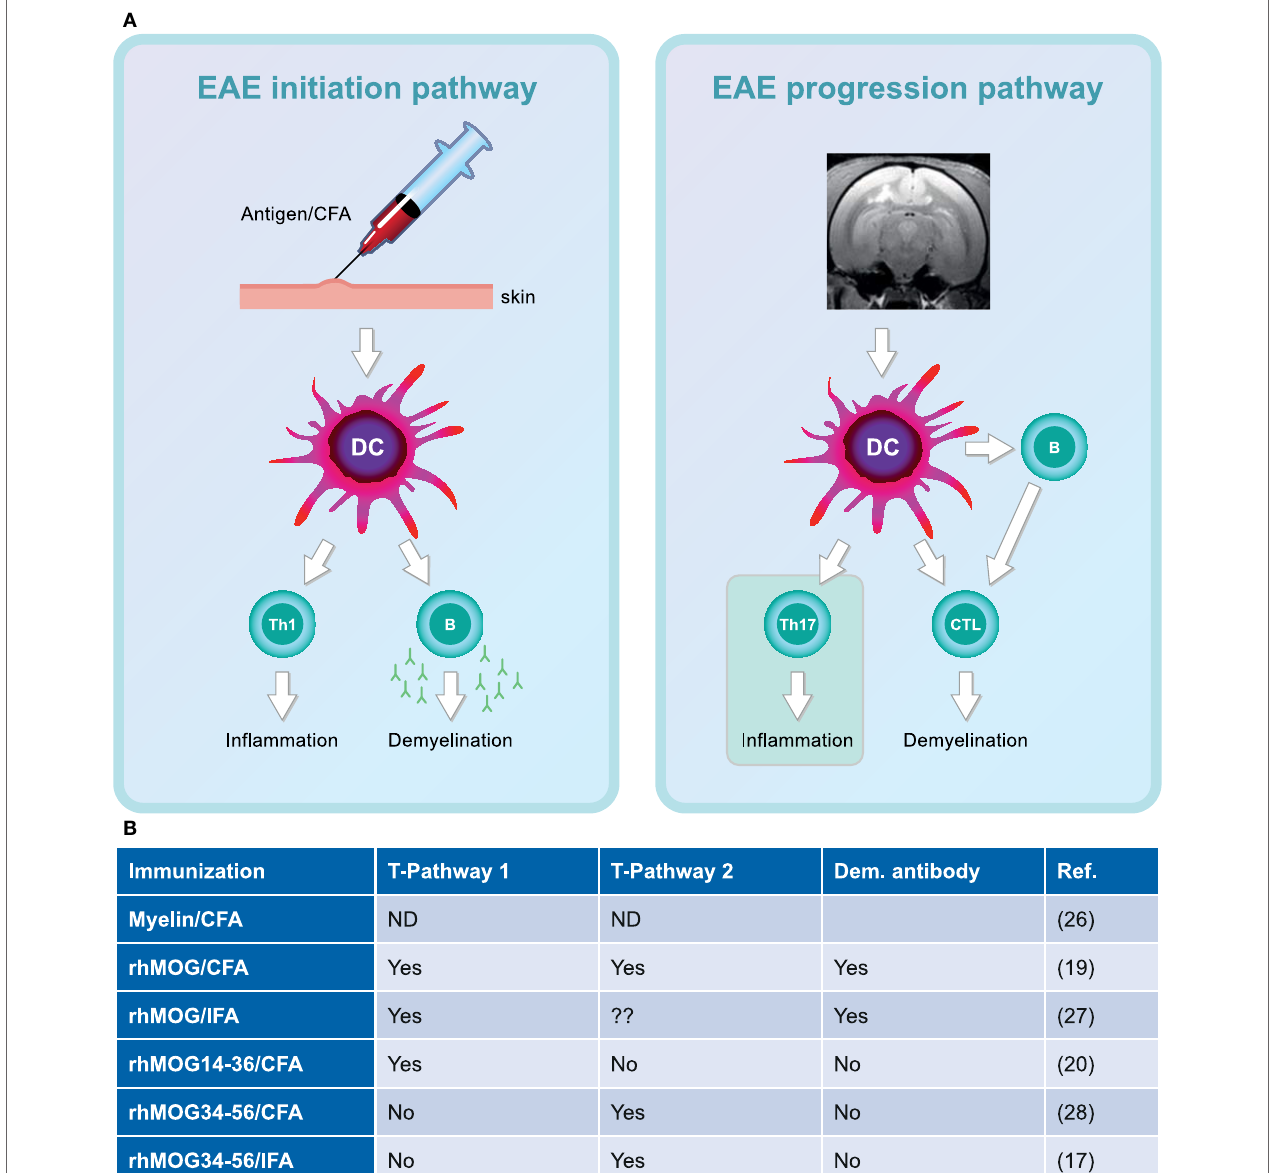
FiGURe 4 | Two-stage immunopathogenesis of experimental autoimmune encephalomyelitis (EAE) in the rhMOG/complete Freund’s adjuvant (CFA)-induced marmoset model. (A) The initiation and progression of EAE in rhMOG/CFA sensitized marmosets are driven by distinct T cell subsets. EAE initiation is mediated by the activation of MHC class II/Caja-DRB*W1201-restricted T helper 1 (Th1)/Th17 cells specific for the epitope 24–36 (EAE pathway 1). EAE progression is driven by MHC class I/Caja-E restricted activation of CD8 + CD56 + cytotoxic T lymphocytes-specific for MOG40–48 (EAE pathway 2). (B) Overview of the involvement of the two pathways in the different EAE